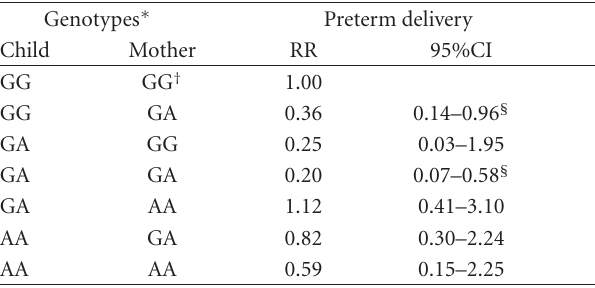
Table 5: Association of combined maternal-fetal TNF - α G308A genotypes with preterm